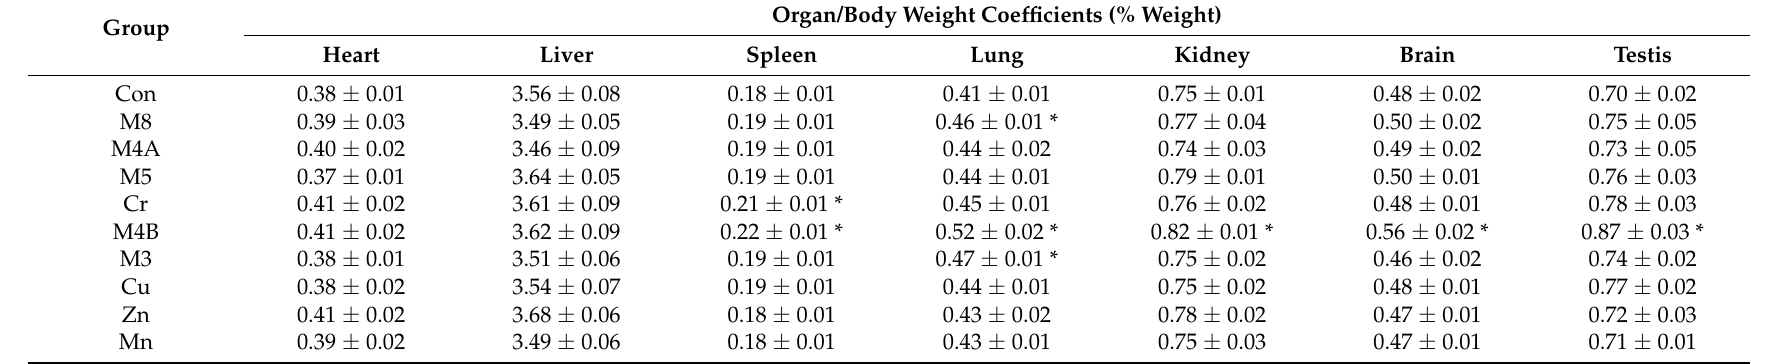
Table 2. Organ/body weight coefficients of rats after treatment with different heavy metal compositions.